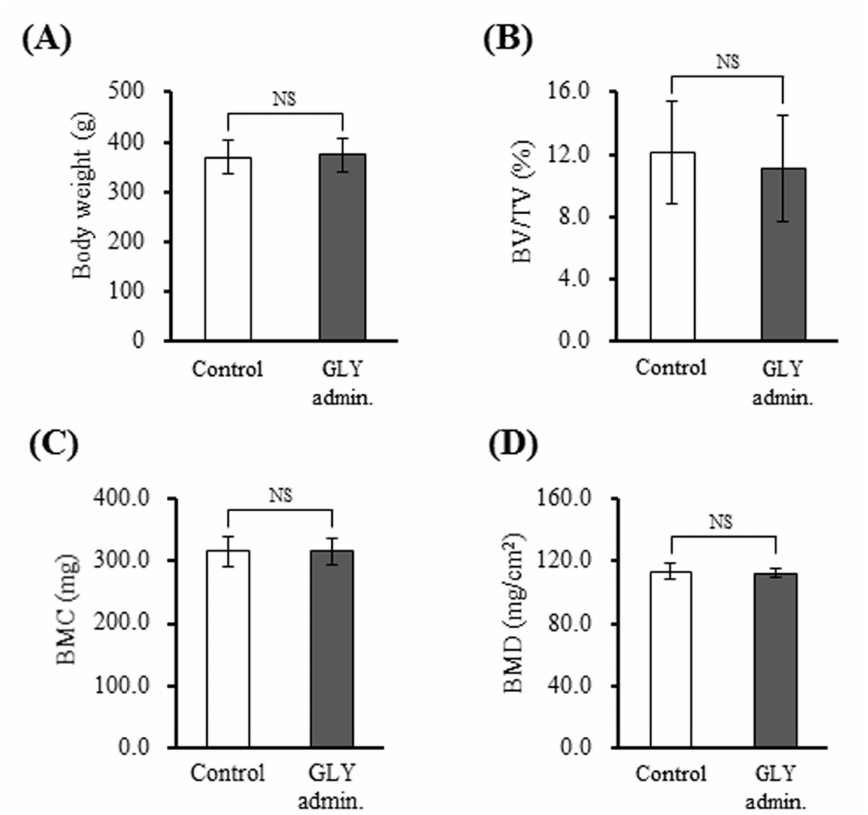
Figure 7. Effects of GLY extracts on systemic bone metabolism. ( A ) Body weights of rats, ( B ) Bone volume fraction (BV/TV, %), ( C ) Bone mineral contents (BMC, mg), ( D ) Bone mineral density (BMD, mg/cm 2 ). Data are presented as the mean ± SD from seven rats per group. NS indicates no significant differences. Control; group of administration of distilled water for 28 days ( n = 7), GLY admin.; group of oral administration with 60 mg/kg GLY extracts for 28 days ( n =